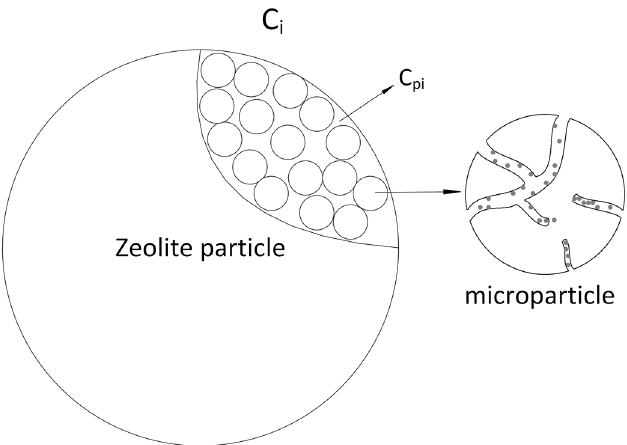
Figure 7. Schematics of the zeolite particle structure.